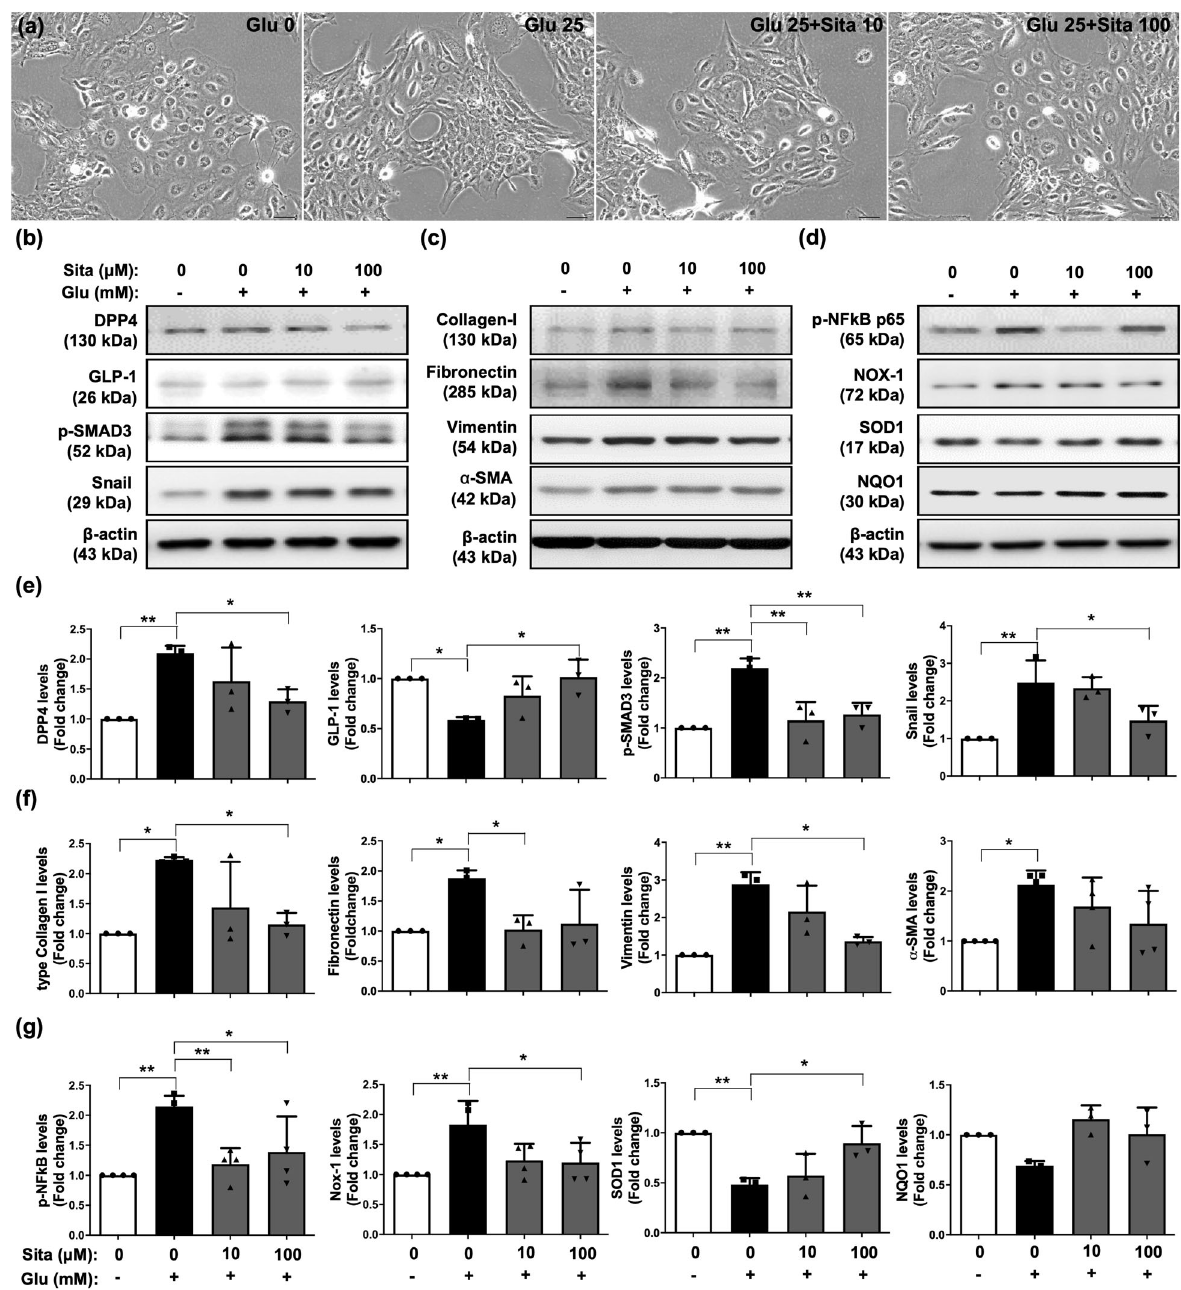
Fig. 2 Sitagliptin suppressed glucose-inducing DPP4 increase, EMT process, in fl ammation, and oxidative stress in mesothelial cells. a Met-5A cells were induced with or without 25 mM D-glucose (Glu) exposure for 120 h. Under 25 mM D-glucose (Glu) induction, Met-5A cells were treated sitaglipin (Sita) with 0, 10, or 100 μ M concentrations, and then observed cell morphology by microcopy at 200×. Scale bars: 50 μ m. b Western blotting was performed to detect the protein levels of DPP4, GLP-1, p-SMAD3, and Snail. c Western blotting was performed to evaluate the protein levels of collagen-I (type I collagen), fi bronectin, vimentin, and α -SMA. d Western blotting was performed to analyze the protein levels of p-NF-kB, NOX-1, SOD1, and NQO1. e – g Quantitative results of Fig. 2b, c, and d were shown, respectively. The relative levels were normalized and compared by 0 mM glucose concentration. Data represents the analysis of at least 3 independent experiments and shows mean ± SD. * indicates p -value < 0.05; ** represents p -value